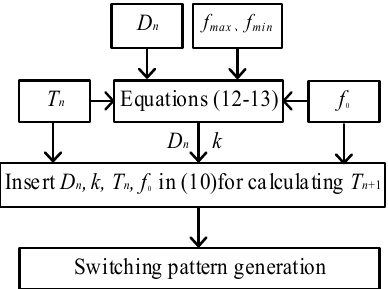
Figure 4. Flow chart of switching cycle calculation.